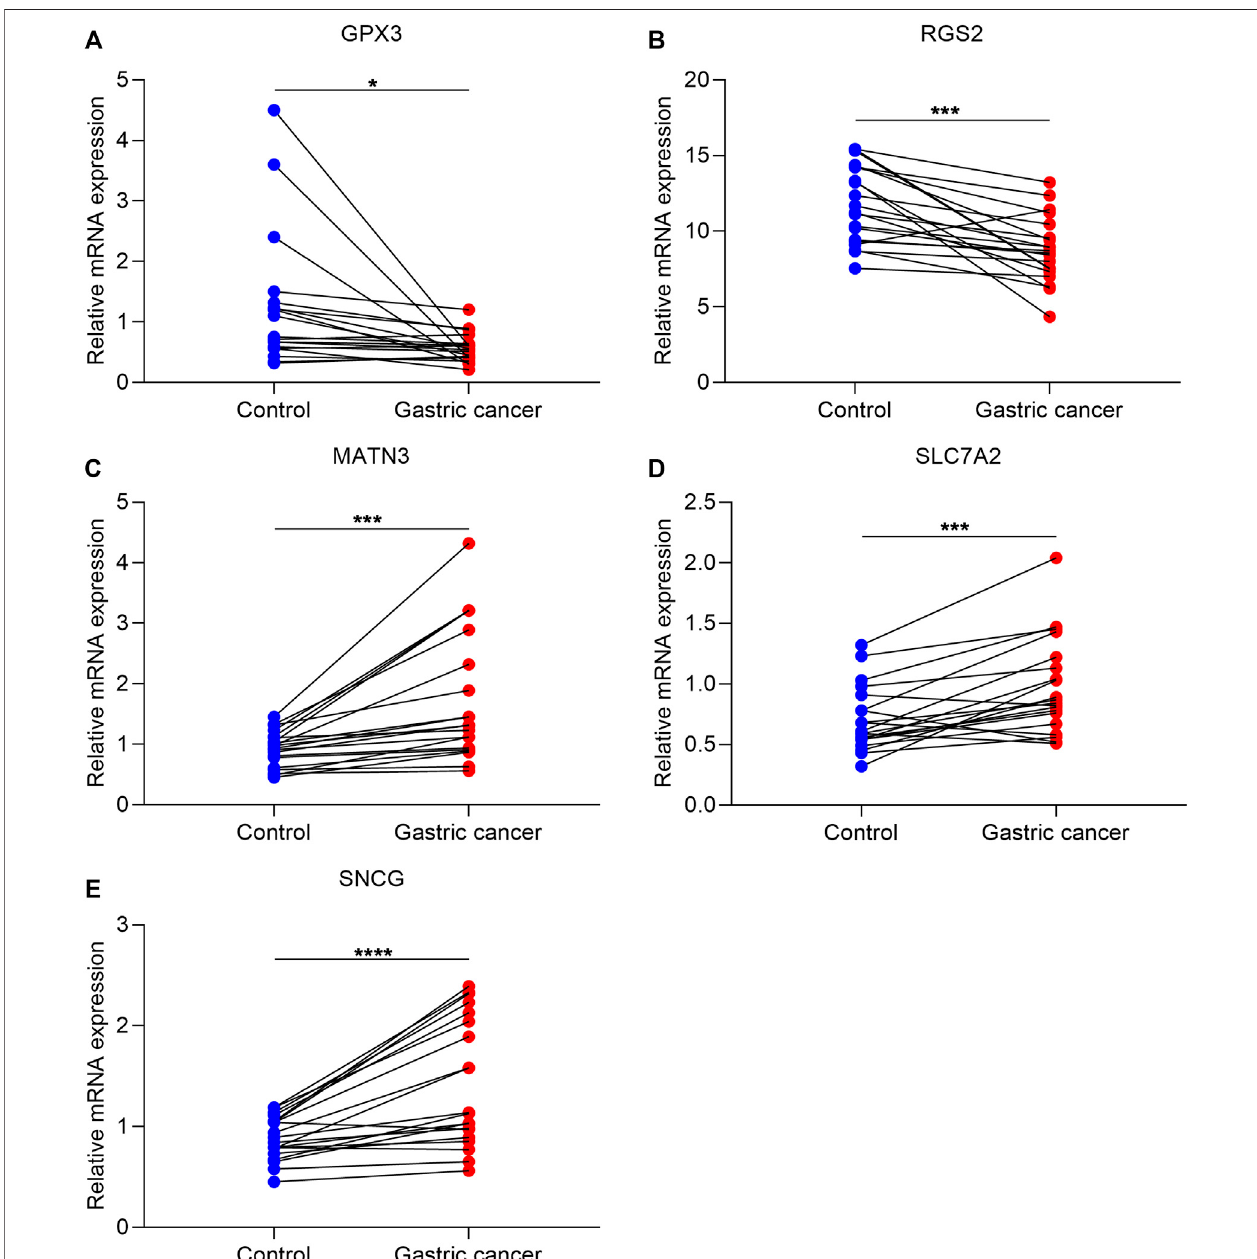
FIGURE 8 | Experimental veri fi cation of altered genes from exosome-based phenotypes. (A – E) qRT-PCR for validating the mRNA expression of GPX3, RGS2, MATN3, SLC7A2, and SNCG in 20 paired GC and para-carcinoma tissues. p p -value < 0.05; ppp p -value < 0.001; and pppp p -value < 0.0001.